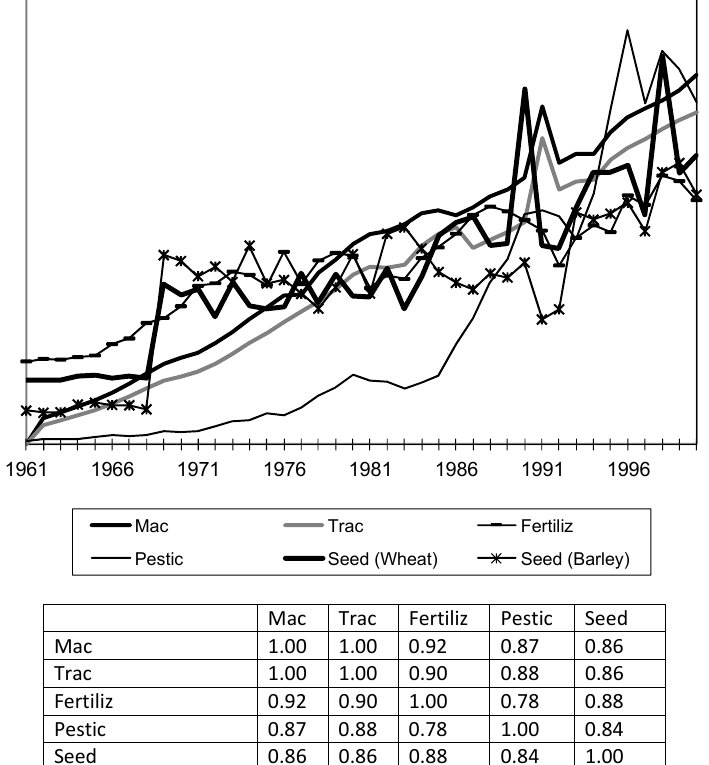
Figure 2. Historical evolution and correlation among the technological factors affecting crop productivity in Spain. Source of data: [8] y